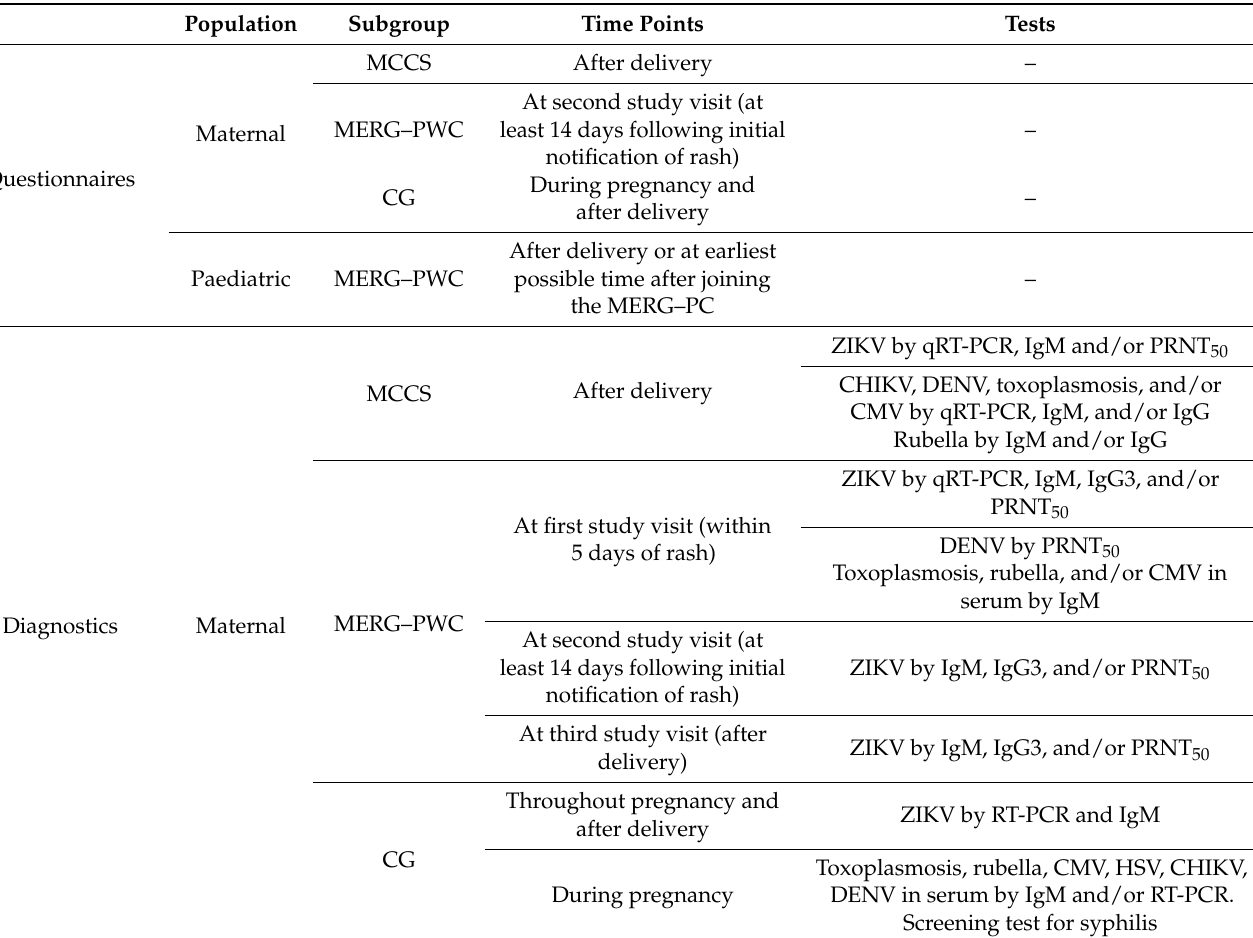
Table 2. Baseline measurements in the